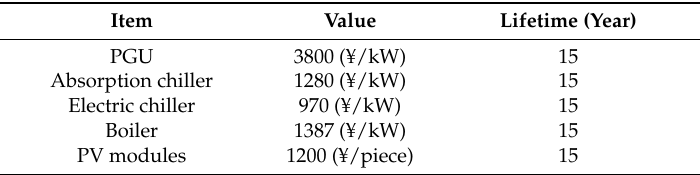
Table 5. Unit prices of used equipment.